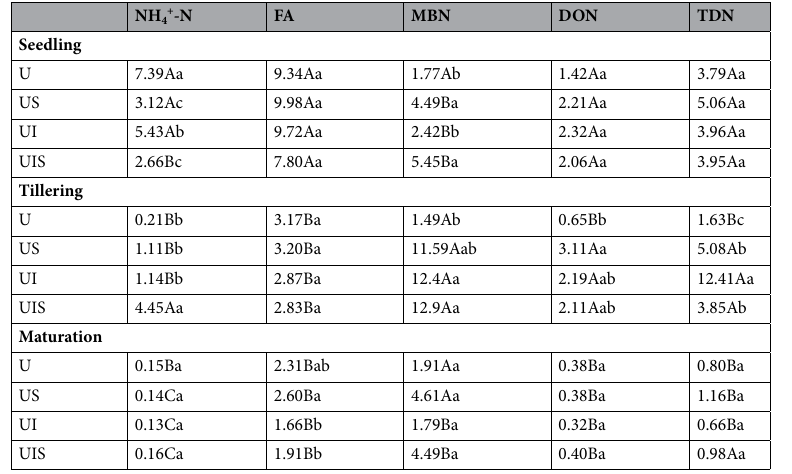
Table 2. Recovery of fertilizer nitrogen in each soil nitrogen pool (%). U: 15 N labeled urea; US: 15 N labeled urea + straw; UI: 15 N labeled urea + inhibitor; UIS: 15 N labeled urea + inhibitor + straw. The values in the table represent the mean of three replicates. NH 4+ -N: ammonia nitrogen derived from urea; FA: fixed ammonia derived from urea; MBN: microbial biomass nitrogen derived from urea; DON: dissolved organic nitrogen derived from urea; TDN: total dissolved nitrogen derived from urea. Different capital letters represent significant differences of the same treatment at different sampling times; different lowercase letters represent significant differences among treatments during the same sampling period (Duncan, P <